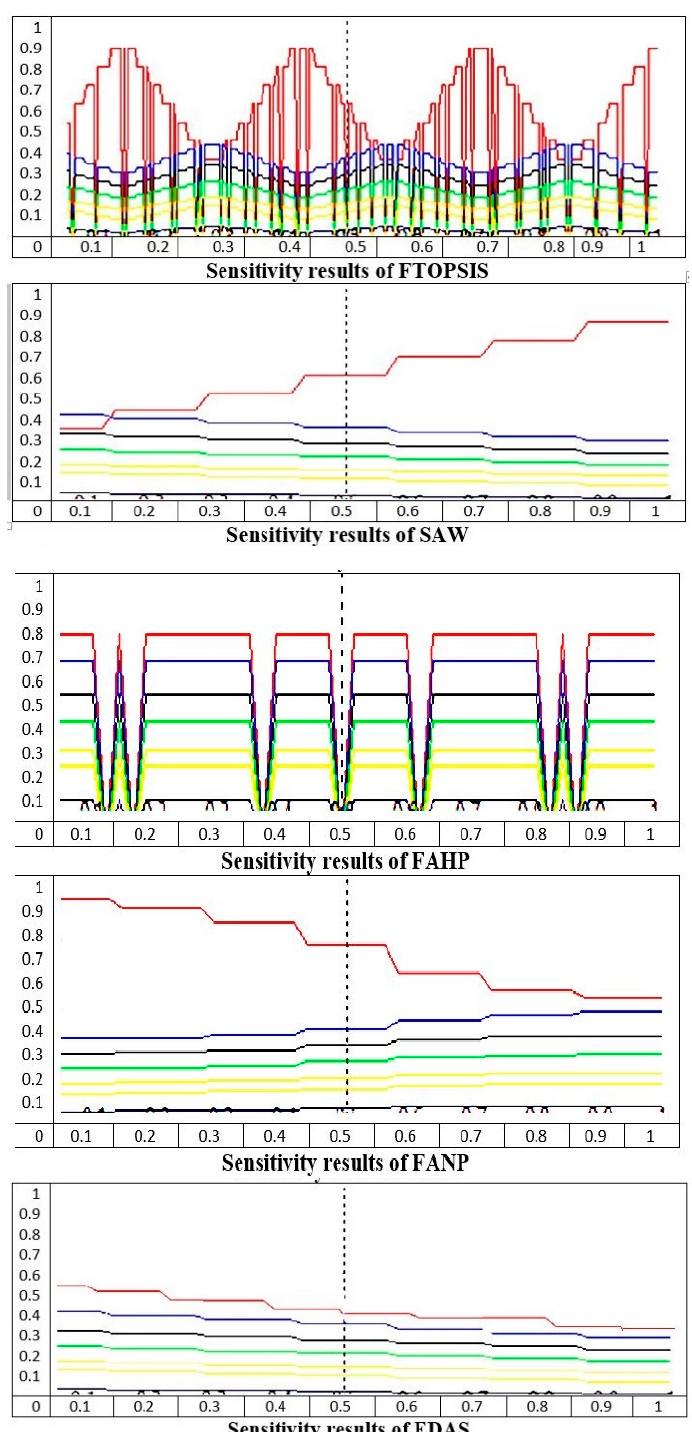
Figure 2. Results of the sensitivity analysis.